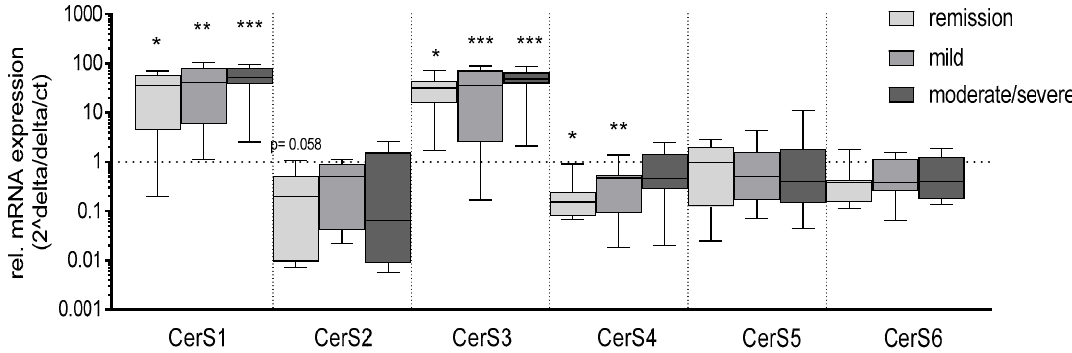
Figure 6. qRT-PCR of CerS in white blood cells from colitis patients and controls. mRNA levels of CerS1-6 in white blood cells (WBCs) were detected by quantitative RT-PCR. CT levels were normalized to GAPDH and subsequently related to the level of the control cohort (set to 1), using 2ˆ(- ∆∆ CT) method. Data are means ± SEM; n = 9–15. Statistical differences were analyzed by one-way ANOVA with α Bonferroni post-hoc test. α = 0.05. (* p < 0.05, ** p < 0.01, *** p < 0.001).